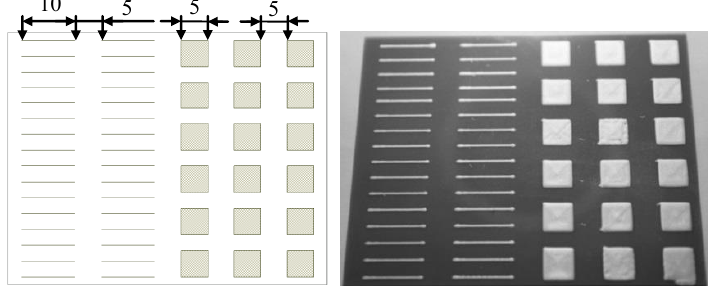
Fig. 2. Experimental sample No. 1: topology (left) and photograph (right).